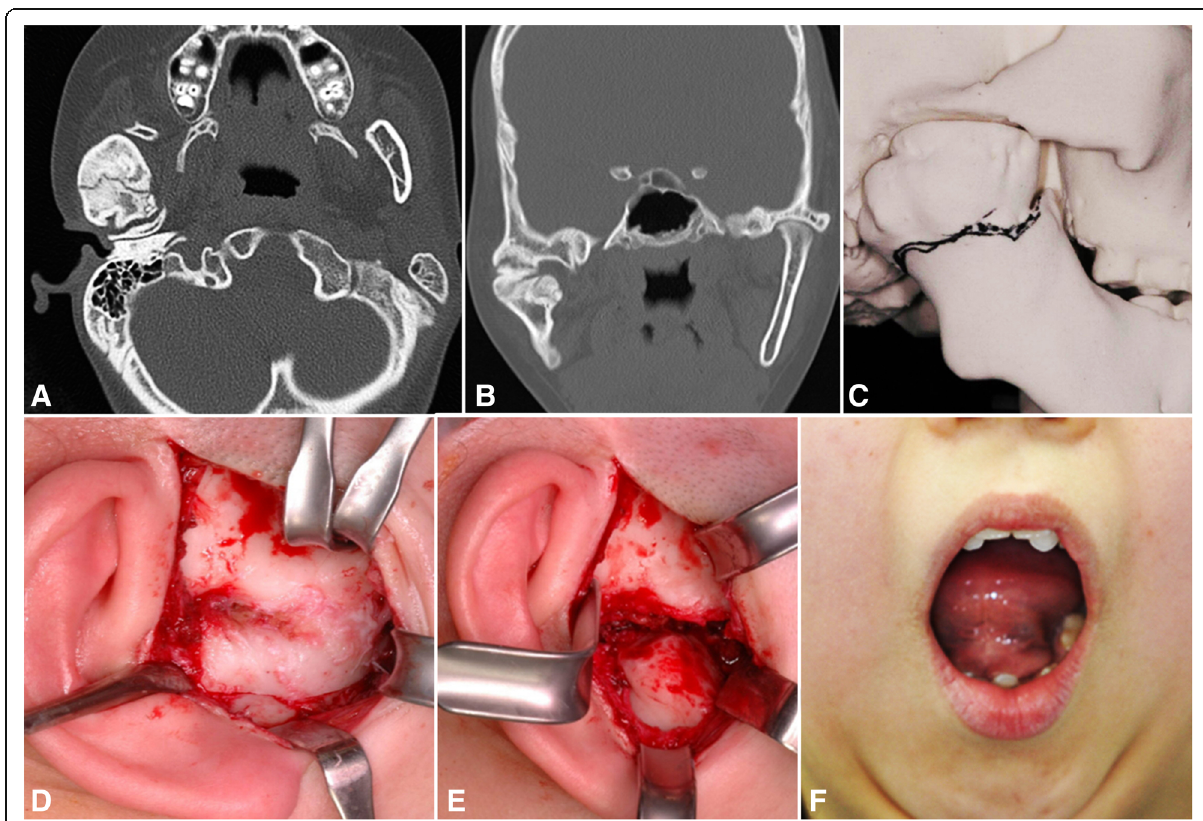
Fig. 5 A 15-year-old female, right side TMJ bony ankylosis secondary to infection, showing axial ( a ) and coronal ( b ) CT scan, RP model used for surgical simulation in gap arthroplasty and coronoidectomy ( c ), endaural approach with ankylosed bony mass ( d ) and complete resection to the medical side of ankylosed mass ( e ), and mouth opening appearance after active mouth opening exercise with an interocclusal splint on 6.5 years later ( f